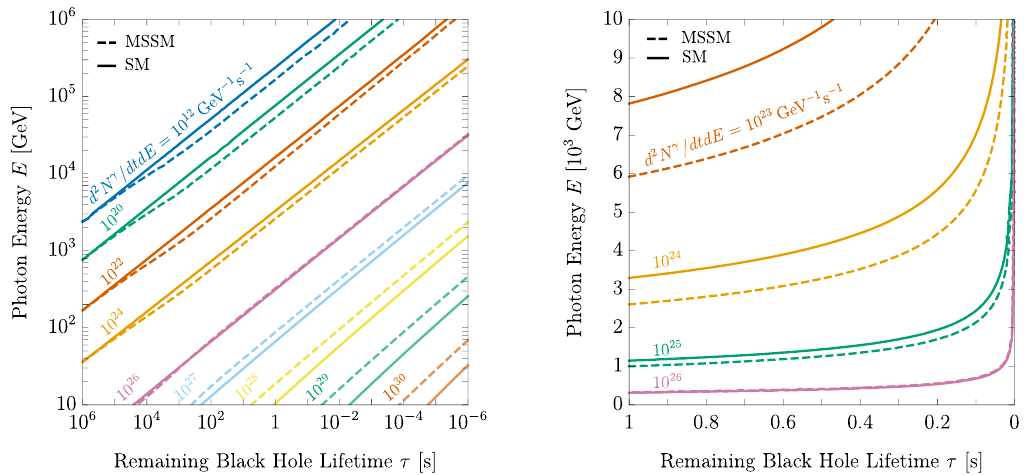
Figure 8 . Contours of the total photon flux as a function of remaining time, τ , and photon energy, E . We show the SM expectation with solid contours and in dashed contours we show the MSSM benchmark. We show the flux on a logarithmic scale (left) and a linear scale (right).